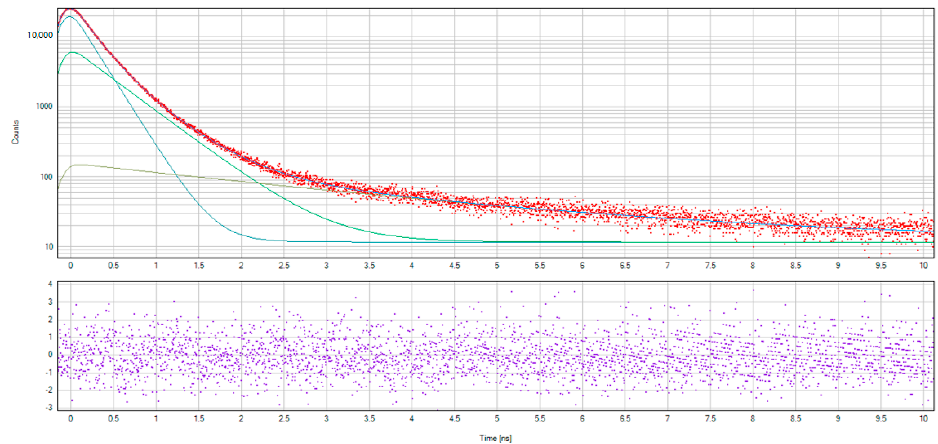
Figure 10. The examples of the fitting spectra using LT10 software.